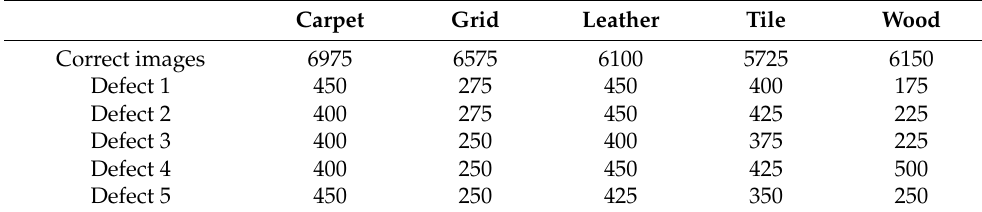
Table 6. Final number of images available in the modified dataset.